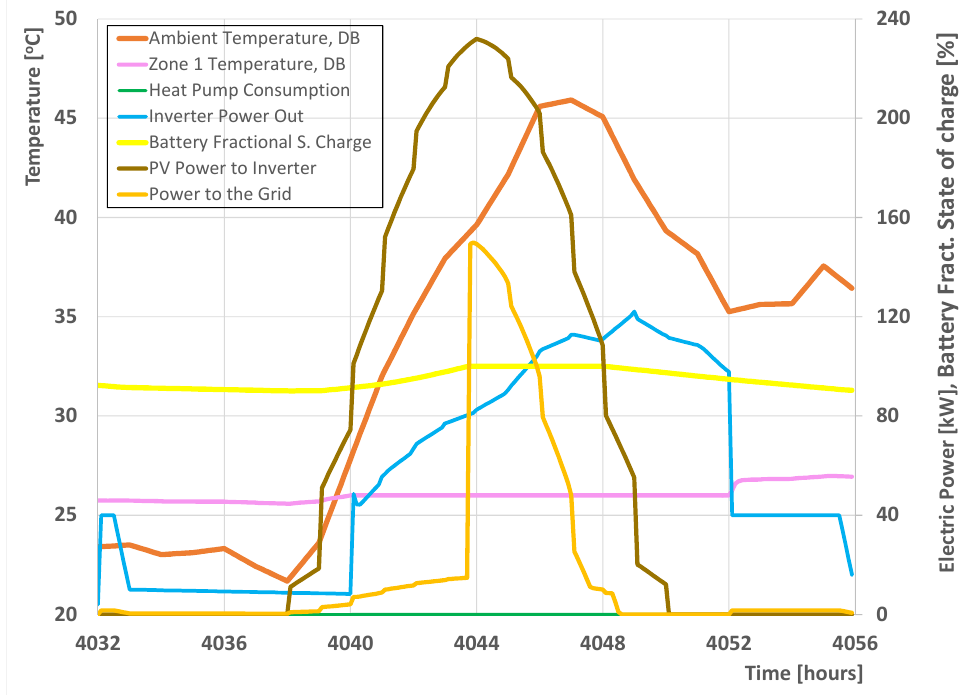
Figure 15. Ambient temperature, room temperature, heat pump electricity consumption, and PV inverter out power during a hot, sunny day in late June, starting at midnight.